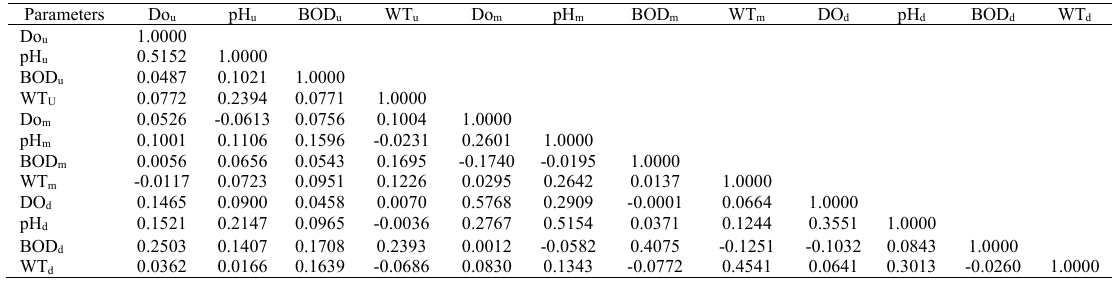
Table 2: Correlation variables used in multi-station modelling